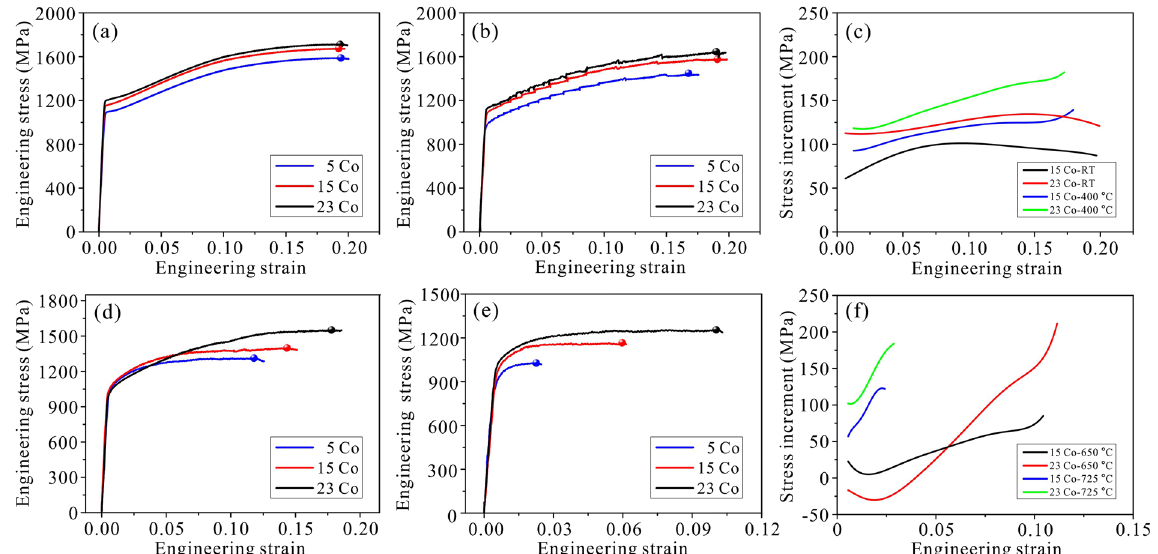
Figure 2. The mechanical behaviors of three alloys under different temperatures. The flow stress-strain curves at ( a ) 25 °C, ( b ) 400 °C, ( d ) 650 °C and ( e ) 725 °C are presented for the three alloys. The colored spheres represent the end of uniform deformation for three alloys, from which ultimate tensile strength (UTS) and uniform elongation (UE) can be obtained. The stress increment is plotted for ( c ) 25 & 400 °C and ( f ) 650 & 725 °C by subtracting the tensile stress of 5Co from that of 15Co or 23Co under similar tensile strain at the same deformation